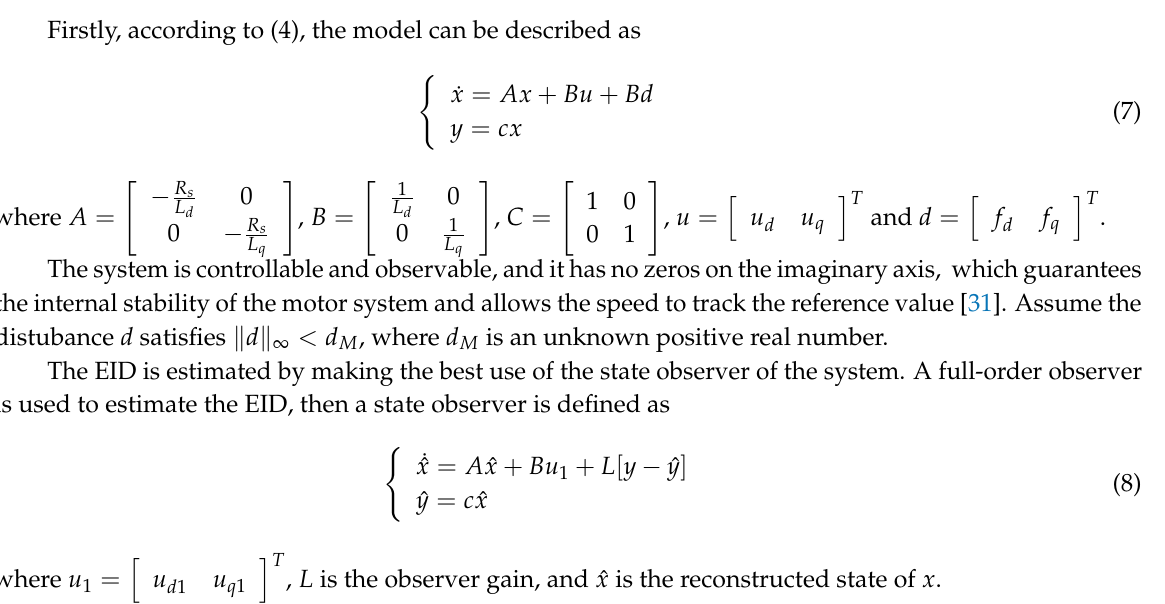
Figure 2. Structural diagram of equivalent-input-disturbance